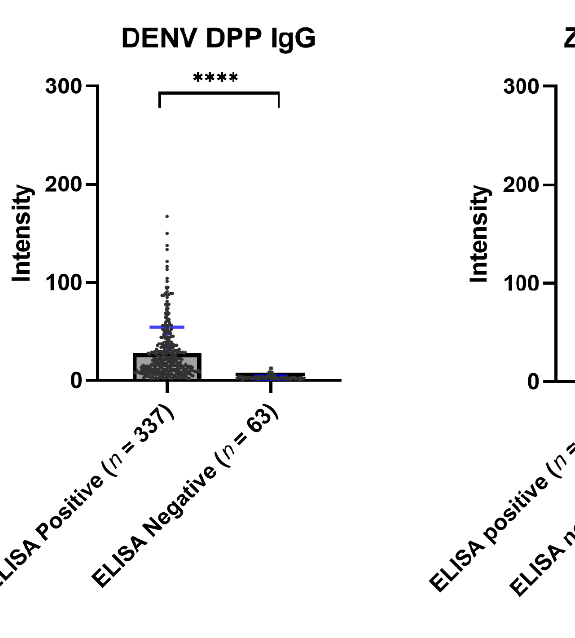
Figure 5. Scatter plot of the DPP ® ZCD system results by ELISA-positive and ELISA-negative samples. The median DENV DPP ® results from ELISA-positive and -negative samples were 18.00 and 2.50, respectively (**** p < 0.0001). The median ZIKV DPP ® results from ELISA-positive and -negative samples were 5.90 and 1.30, respectively (**** p < 0.0001). The median CHIKV DPP ® results from ELISA-positive and -negative samples were 14.50 and 2.10, respectively (**** p < 0.0001).